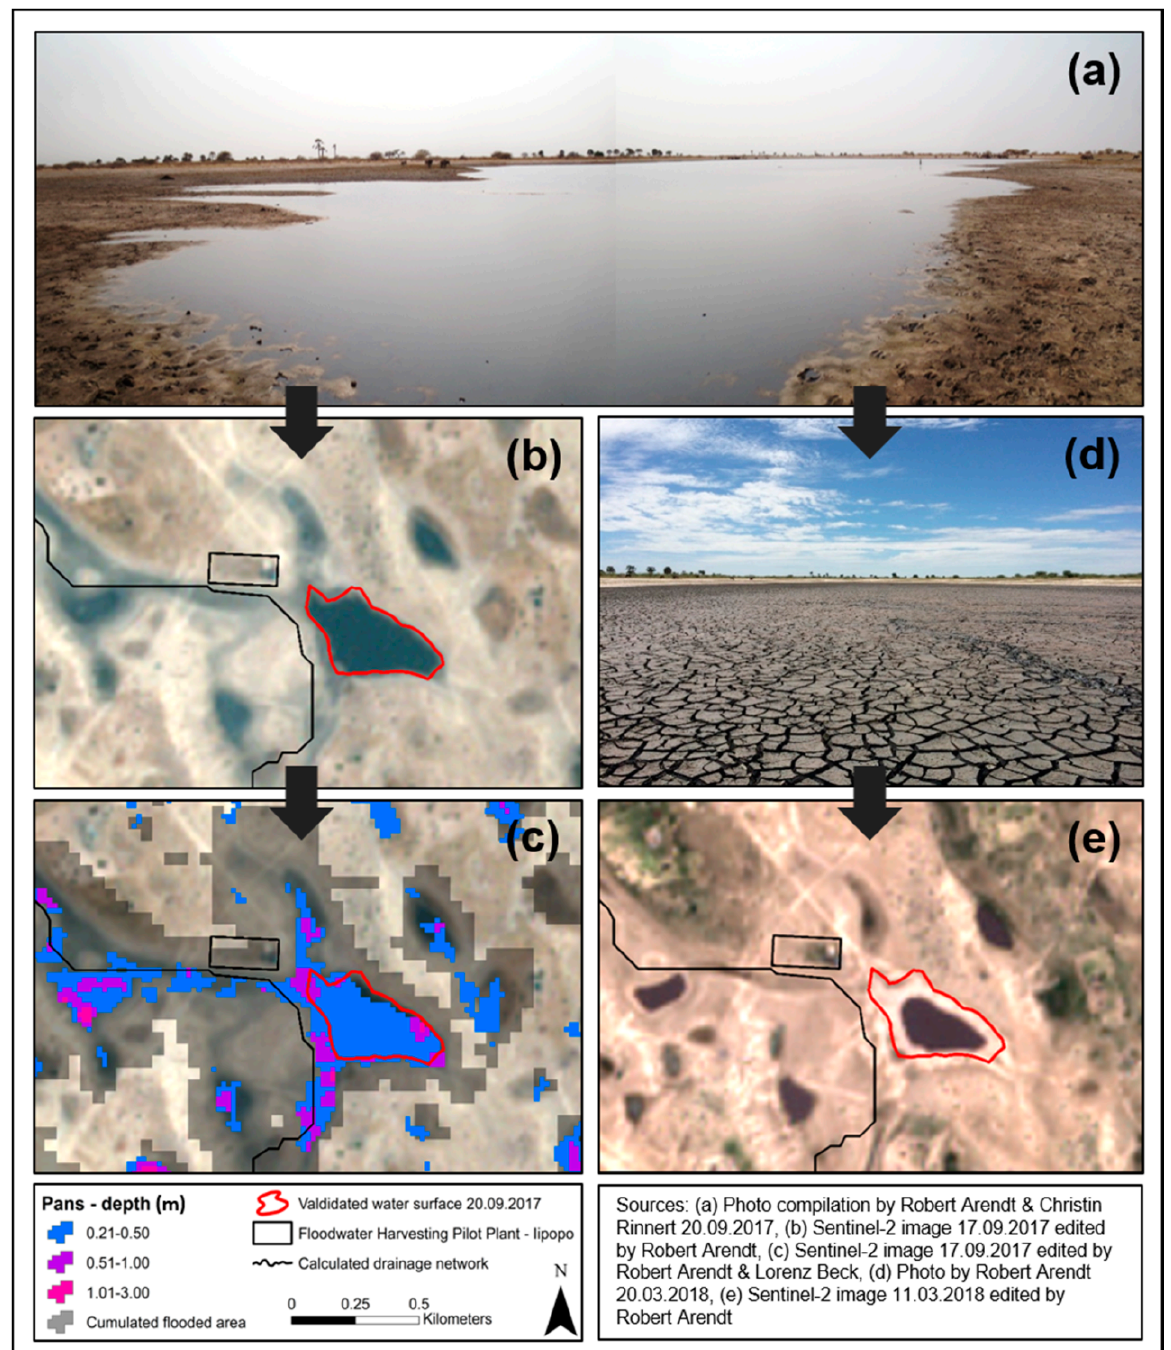
Figure 5. Validation process of pan detection. Example also represents focus area 4, annotated in Figure 7. Subfigure ( a ) shows the situation and water extend on site in 2017. The red shape in subfigure ( b ) determines the surface water area of ( a ) and corresponds to the water surface area detected via the satellite data in 2017 ( b ). Subfigure ( c ) shows the result of the calculated depths and extent of the pans. Additionally, the gray areas show the maximum flood water extent detected in the past. In subfigure ( d ) the appearance of the depression in a dried out state is illustrated. This condition was documented by photo in 2018 after a drought event. Subfigure ( e ) shows the same dry pan by a satellite image including the former red shape of the water extend of 2017. Here, the dark area does not represent water, but dry